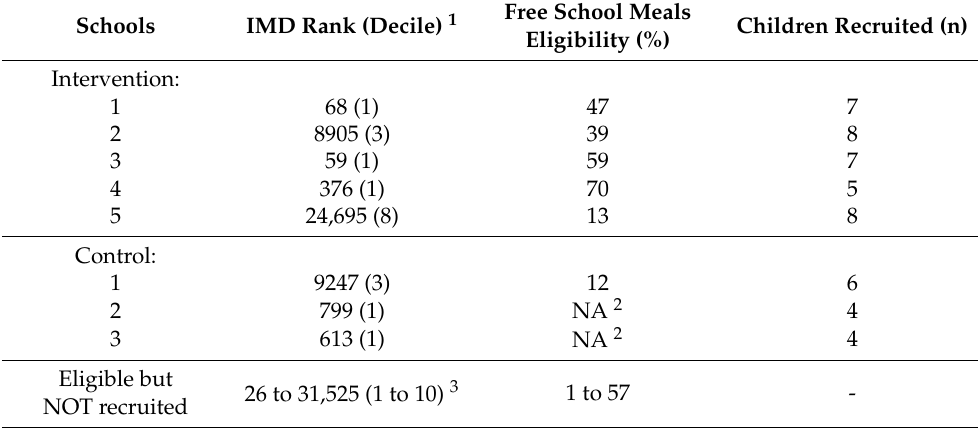
Table 1. Demographics of Intervention and Control settings (index of multiple deprivation (IMD), free school meals and children